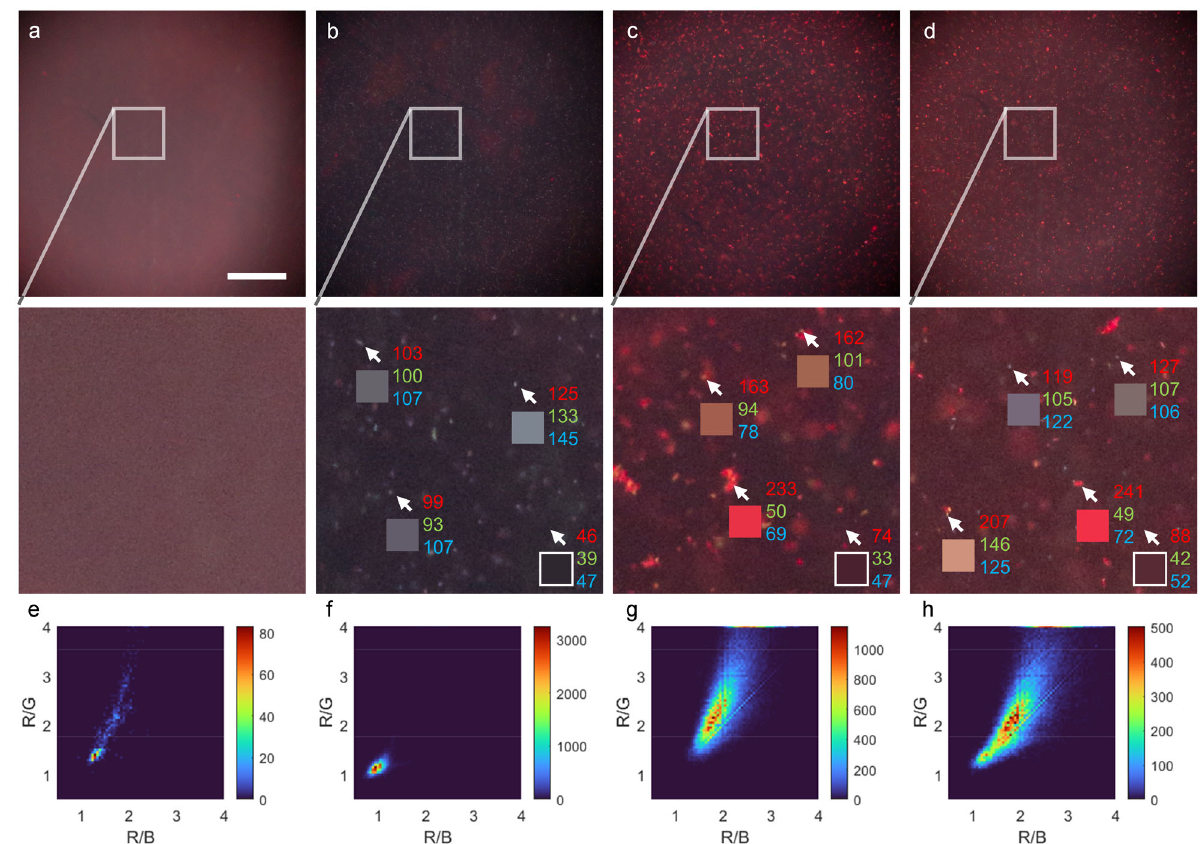
Fig. 9 Images of bacterial samples acquired with Pocket MUSE. Two different populations (Gram + and Gram-) of bacteria can be separated with Pocket MUSE. Aliquots of ( a ) deionized water, ( b ) an E. coli (Gram-) culture, ( c ) a B. subtilis (Gram + ) culture, and ( d ) a mixture of E. coli culture and B. subtilis culture imaged with Pocket MUSE. All samples were stained with 0.01% w/v DAPI and 0.02 % w/v WGA-AF594, and imaged under the same conditions. Images show ( a ) no bright spots, ( b ) blue-grayish spots, ( c ) a mixture of reddish and orangish spots, and ( d ) a mixture of blue-grayish, reddish and orangish spots dispersed across the FOV. For each image, a close-up view of the region labeled with the box (box size: 250 × 250 µ m 2 ) is shown below. For ( b ) – ( d ), the center pixels of three bright spots in each image, pointed to by the arrows, are shown in the boxes below. The RGB values (top to bottom) of the pixels are labeled on the side. The nucleic acid in E. coli (DAPI stain) contributes to the blue-grayish speckles (R ≈ G ≈ B). Peptidoglycan on the B. subtilis surface (WGA-AF594 stain) contributes to the reddish speckles (R > G + B). Nucleic-acid-rich endospores in B. subtilis contribute to the orangish speckles (R > G, R > B & R < G + B). e – h bivariate histogram representation of the bright pixels in ( a ) – ( d ), showing the distribution of colors. All images were median- fi ltered and background-corrected before analysis. Only bright pixels are counted (e.g., four times greater than the mean value of the corresponding image). X -axises represent the ratio between red and blue channels. Y -axises represent the ratio between red and green channels. Scale bars: 300 µ